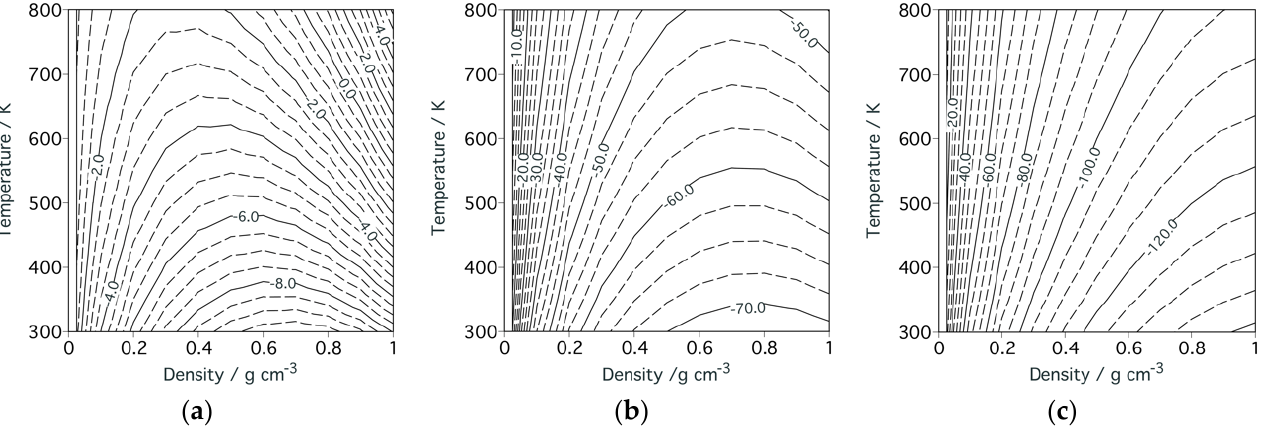
Figure 15. Density and temperature dependence of the solvation free energy: ( a ) H 2 O, ( b ) H 3 O + , and ( c ) OH − . The units of the numbers on isochore lines are kcal mol − 1 . These figures are reprinted with permission from JPCB , 2006 , 110 , 8451. Copyright 2006 American Chemical Society.